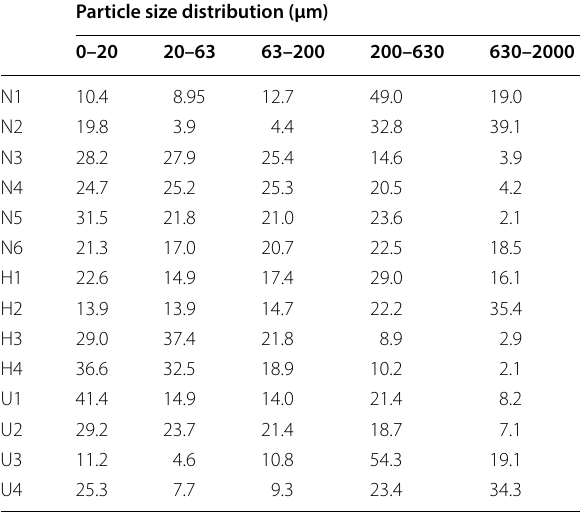
Table 4 Particle size distribution from the main sampling sites exemplarily shown for the sampling event in winter/ spring 2016 as measured by the particle size